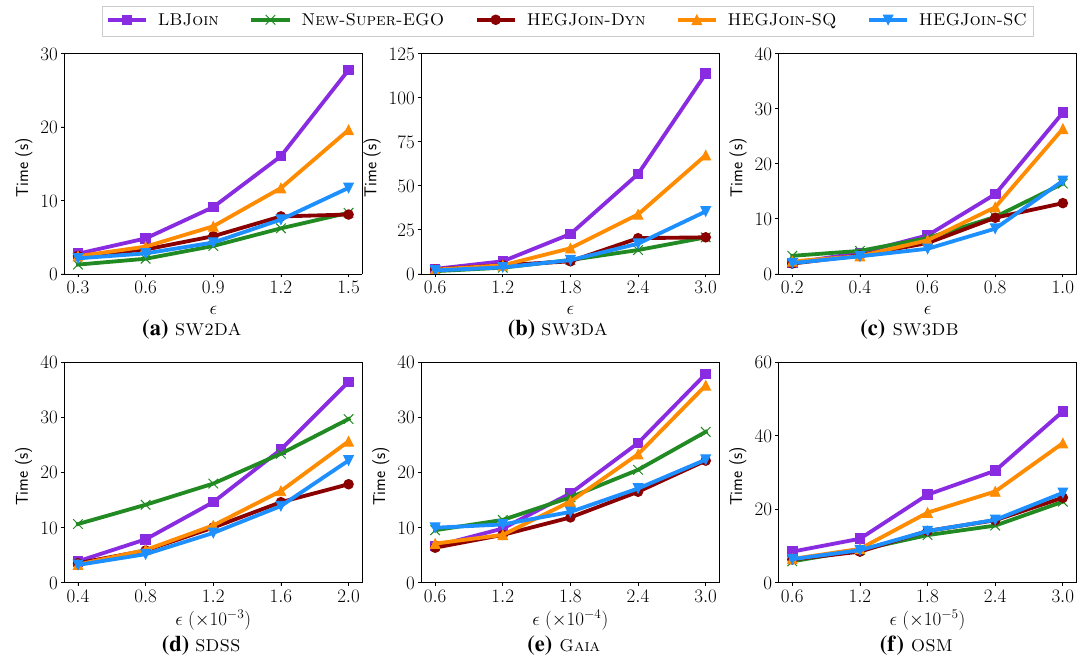
Fig. 11 Response time of HEGJ oin -d yn , HEGJ oin -SQ , HEGJ oin -SC , LBJ oin , and n Ew -S upEr -EGo on ( a ) SW2DA , b SW3DA , c SW3DB , d SDSS , e Gaia , and f OSM . S is in the range a 295–5.82 K, b 239–13.2 K, c 33–2.13 K, d 1–31, e 19–455, and f 67–571. Results from Platform